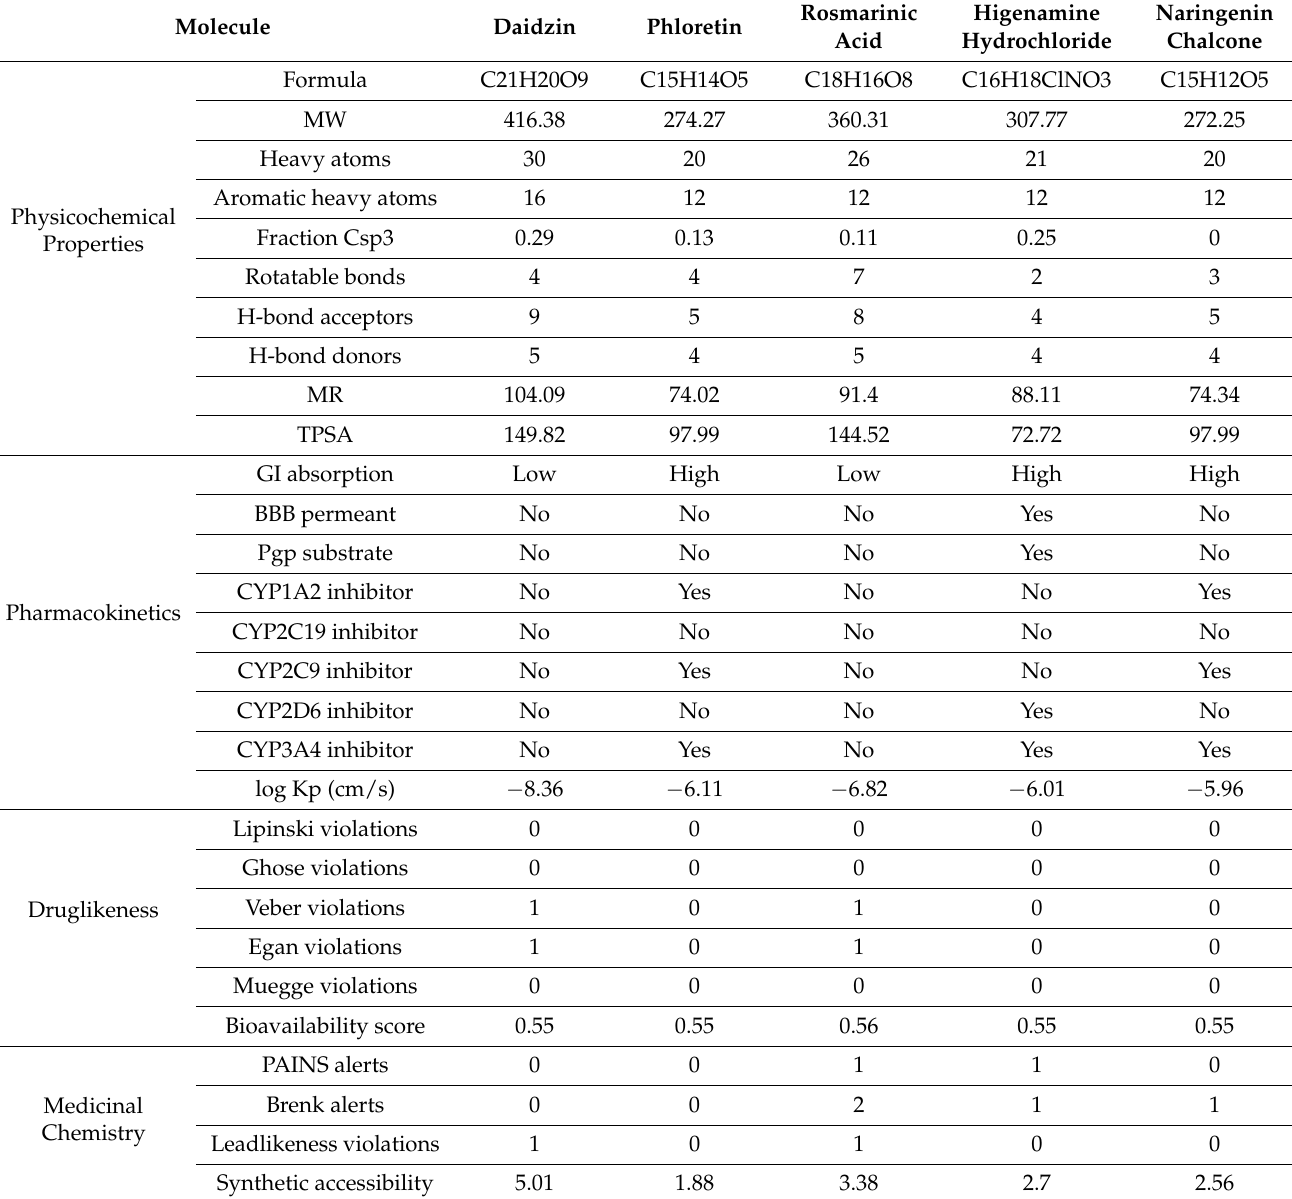
Table 2. Physicochemical properties of selected